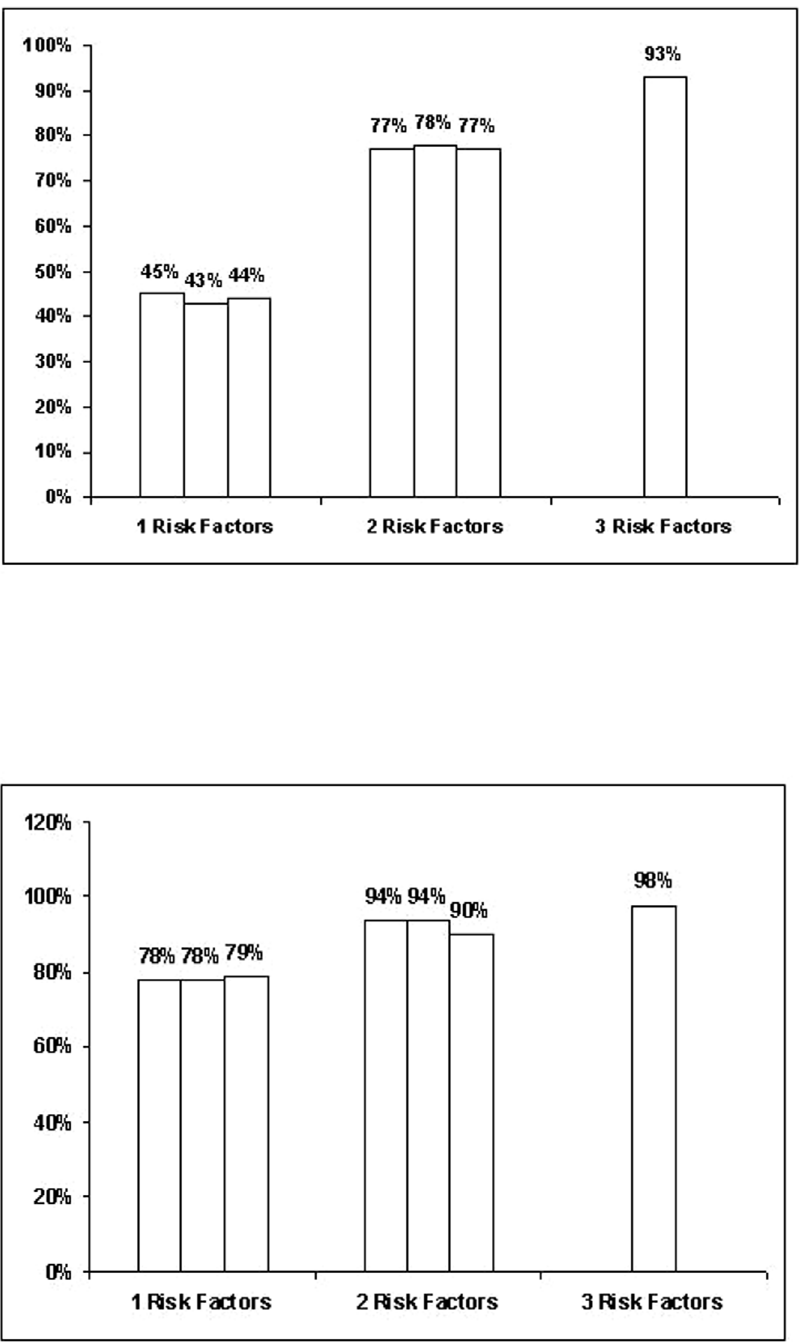
Figure 2. Prognostic probability of developing AKI in severe rhabdomyolysis according to risk factors at hospital admission. Percentages indicate the proportion of patients developing AKI if creatine phosphokinase (CK) is above or below 1,2750 IU/L and additional risk factors are present (e.g., a patient with hypoalbuminemia [ , 33 g/l], metabolic acidosis, PT , 82% and peak CK . 1,2750 IU/L has a 98% likelihood of developing AKI). Figure 2A: CPK # 12,750 IU/L. Figure 2B: CPK . 12,750 IU/L. used RIFLE criteria to stratify the severity of AKI and to predict were classified according to these ADQI stages but statistical prognosis in patients with acute rhabdomyolysis at the emergency differences between the different ADQI stages were not observed setting. [24] The RIFLE categories correlated significantly with (data not shown). The lack of correlation was probably related to the known markers of rhabdomyolysis and AKI. These categories also fact that most patients were classified into the ‘‘failure’’ stage. predicted length of stay, need for dialysis procedures, renal morbidity, The mortality rate was 13%. This reinforces the poor prognosis of and timing of recovery. In our study, patients who developed AKI this disease, a serious condition that often leads to acute kidney failure